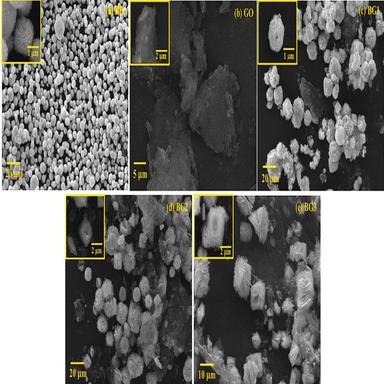
SEM images of (a) BB, (b) GO, (c) BG1, (d) BG2 and (e) BG3 nanomaterials.